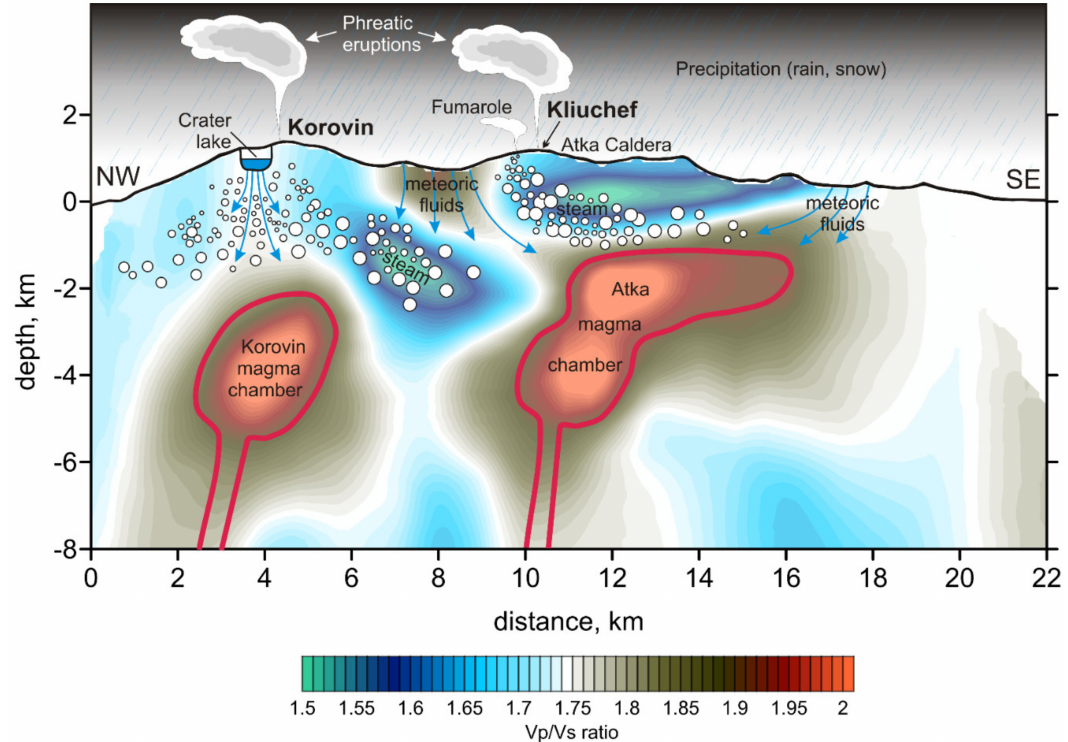
Figure 7. Conceptual representation of the magmatic and geothermal system beneath Atka Volcanic Complex (AVC), based on the distribution of the Vp / Vs in vertical section A1–B1 (Figure 6). Blue arrows indicate possible paths of downgoing flows of meteoric waters. White circles schematically depict the areas saturated with steam. Red contours highlight the active magma chambers beneath the Korovin and Kliuchef